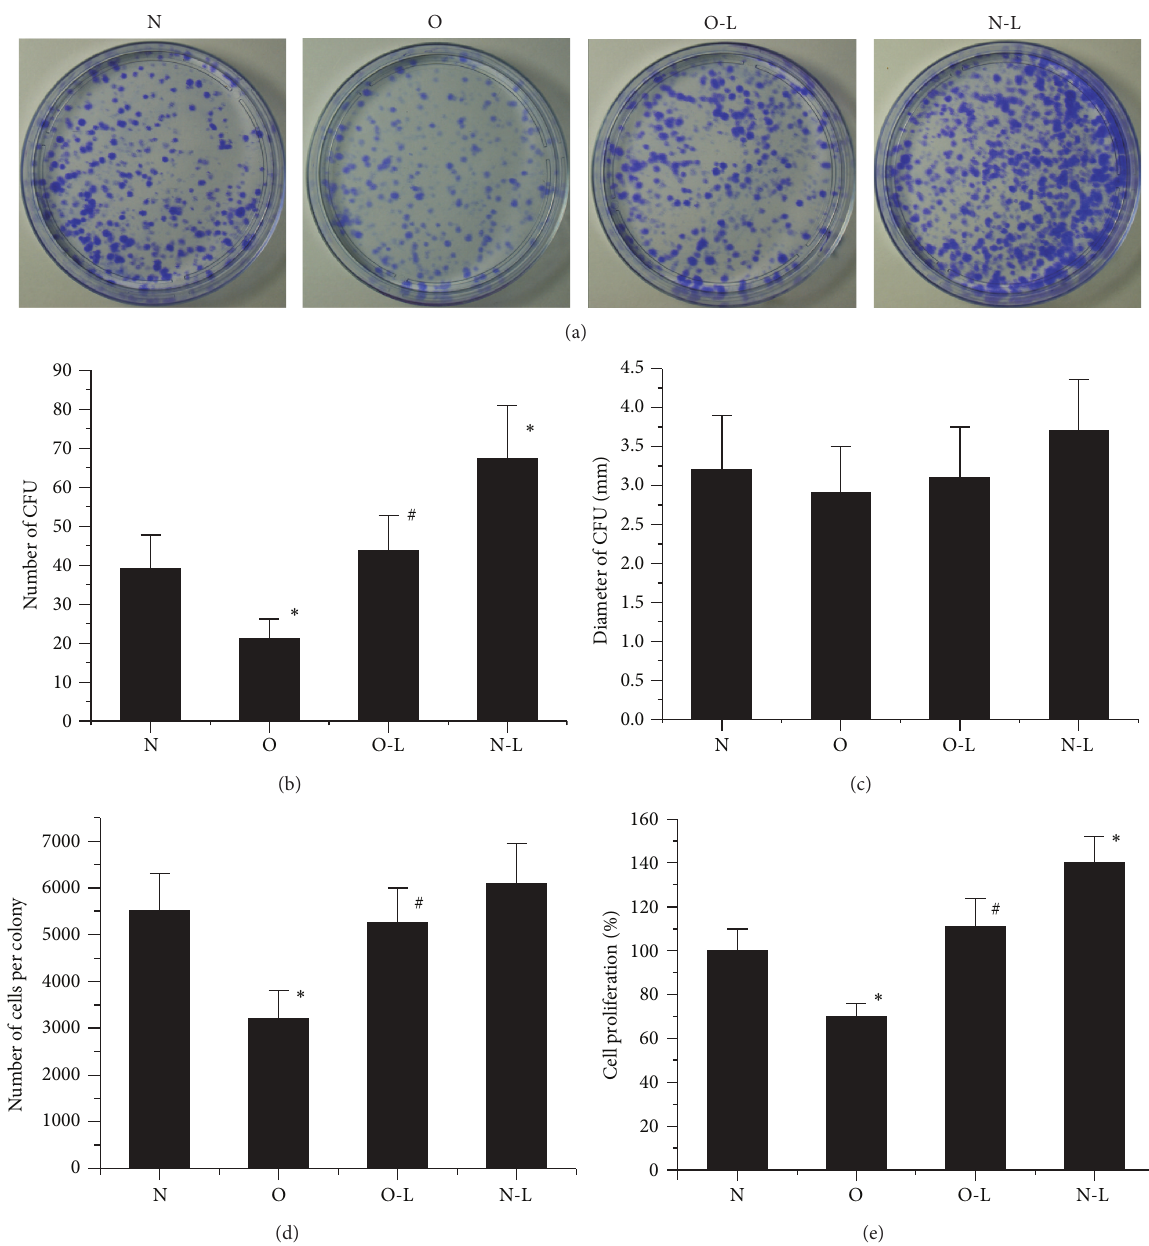
Figure 1: The colony-forming unit and proliferation of MSCs. (a) Representative photograph of colonies in CFU-A at day 7. (b) Number of CFU detected per 10 6 of seeded cells in CFU-A. (c) Average diameter of CFU. (d) Average number of cells per colony in CFU-A. (e) Cell proliferation was measured by WST-1 assay. The optical density (OD) value of normal MSCs was used as 100% cell proliferation. The data were drawn from three independent experiments and the results were expressed as mean ± SD. ∗ 𝑃 < 0.05 versus N Group. # 𝑃 < 0.05 versus O